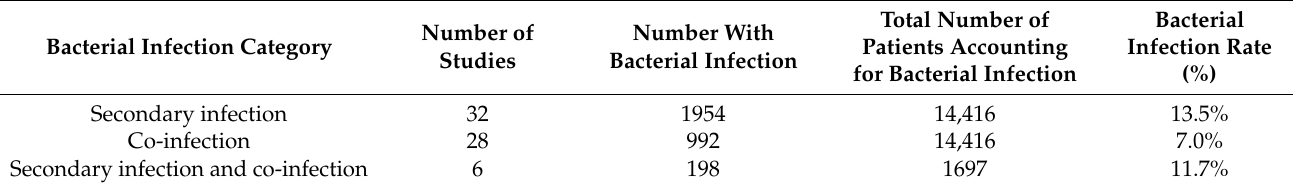
Table 9. Bacterial infection type and infection rate in COVID-19 patients.